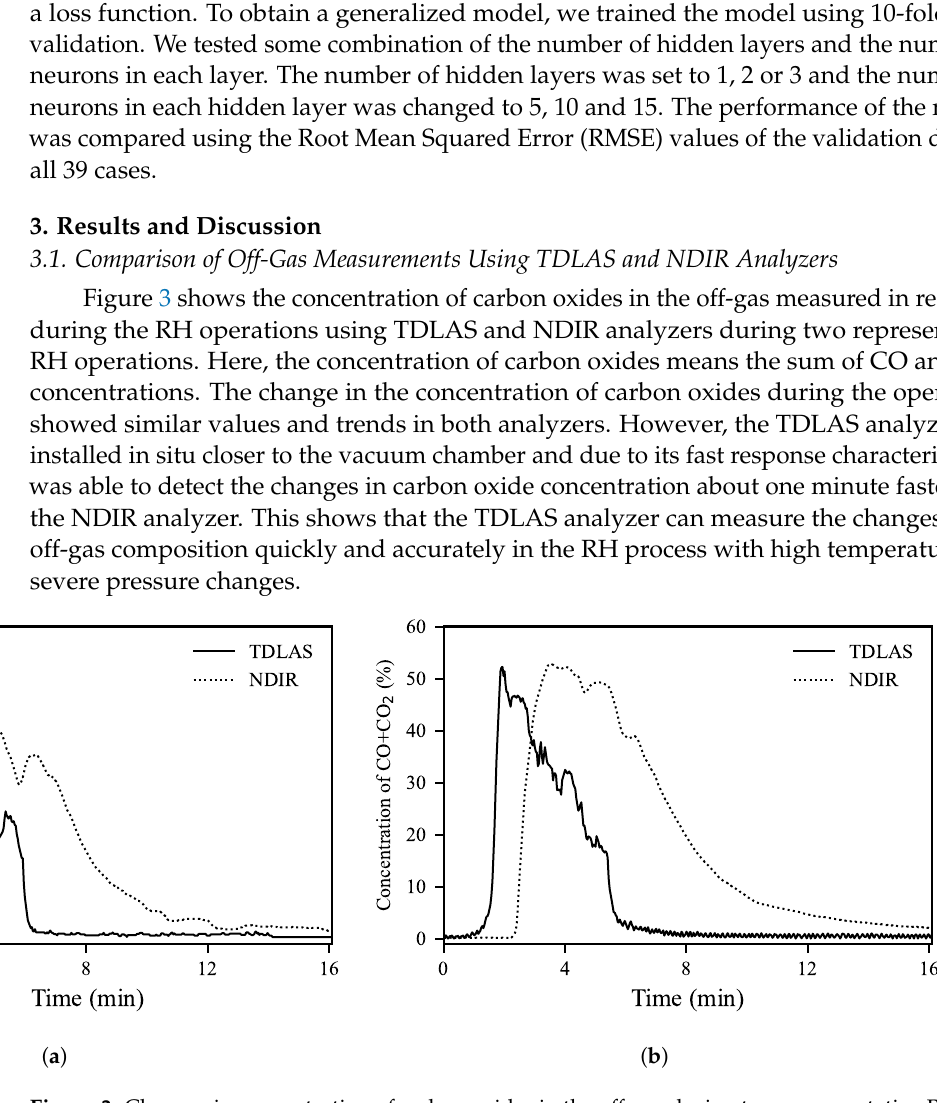
Figure 3. Changes in concentration of carbon oxides in the off-gas during two representative RH oper- ations measured by TDLAS (solid lines) and NDIR (dotted lines) analyzers. Each graph represents the sum of the CO and CO 2 concentrations measured at each time point. ( a ) Secondary decarburization is clearly shown. ( b ) Secondary decarburization did not